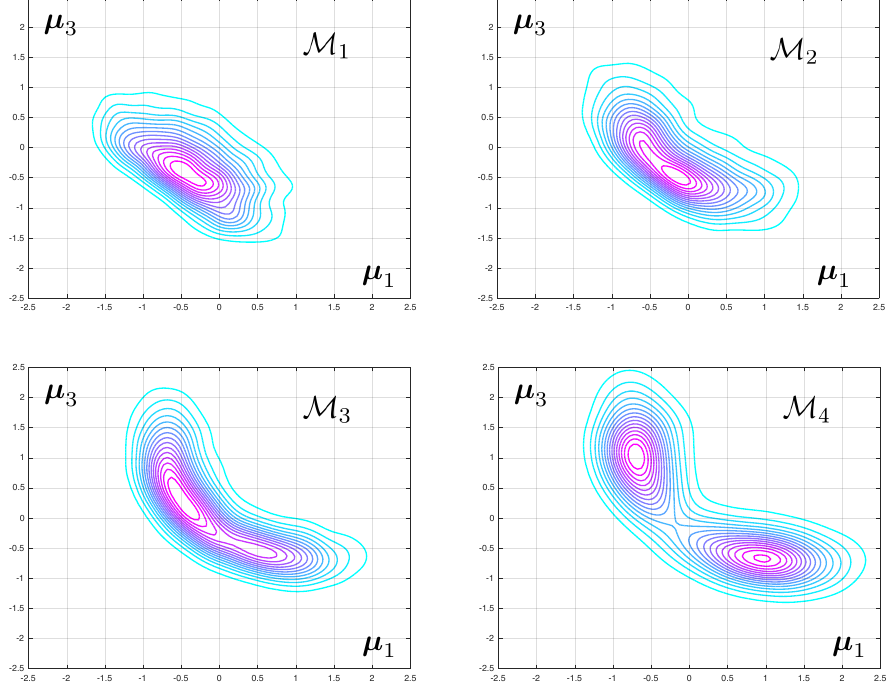
Figure 4. Evolution of the joint posterior density of two of the unknown elasticity parameters as the computational mesh is progressively refined from